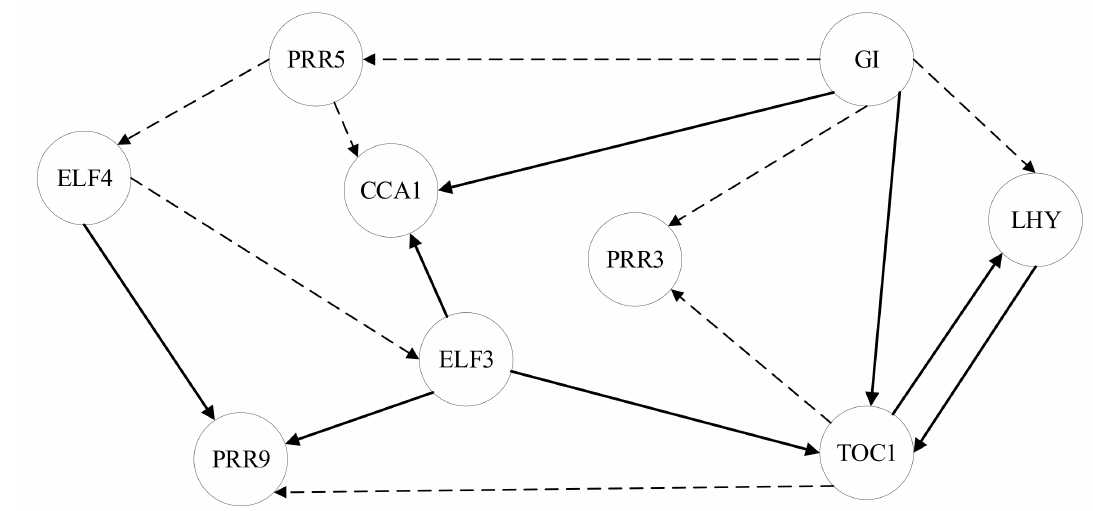
Figure 11. Arabidopsis gene regulatory network inferred by the PCCs-ED-DBN model.